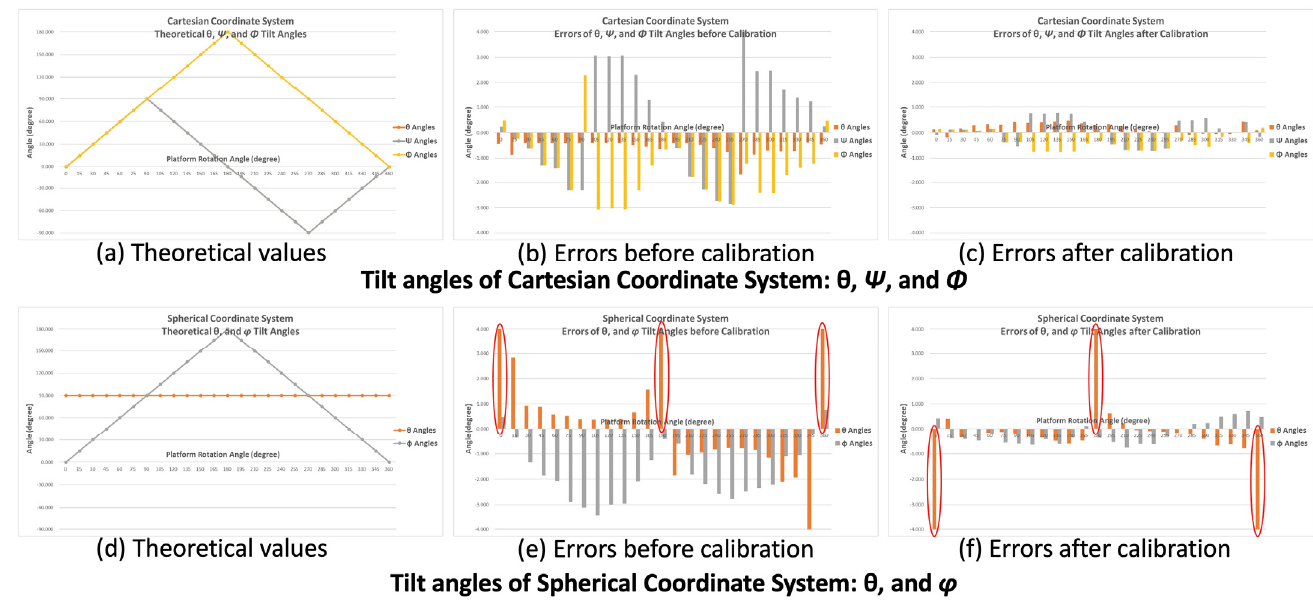
Figure 10. Plots of the tilt angles. θ , Ψ , and Φ in the Cartesian coordinate system. ( a ) Theoretical values. ( b ) Errors of angles calculated from raw acceleration data before calibration. ( c ) Errors of angles calculated from calibrated acceleration data. θ and φ in the Spherical coordinate system. ( d ) Theoretical values. ( e ) Errors of angles calculated from raw acceleration data before calibration. ( f ) Errors of angles calculated from calibrated acceleration data.